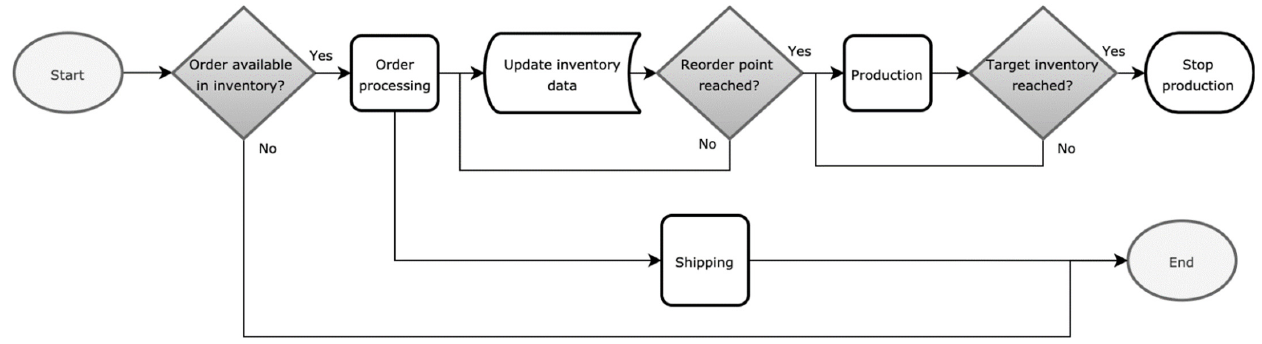
Figure 5. Flowchart of the current supply chain configuration of the pipe tee joint manufacturing company.